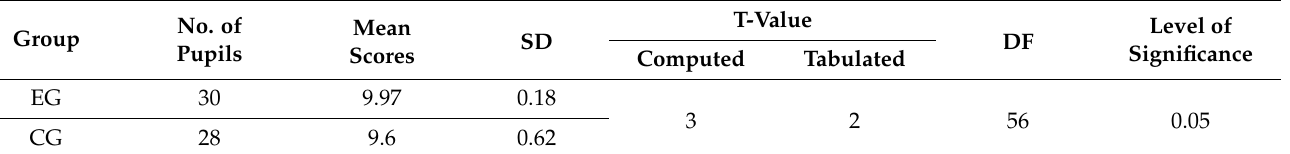
Table 13. The Mean Scores, Standard Deviations, and T-Values of the EG and CG in the Third